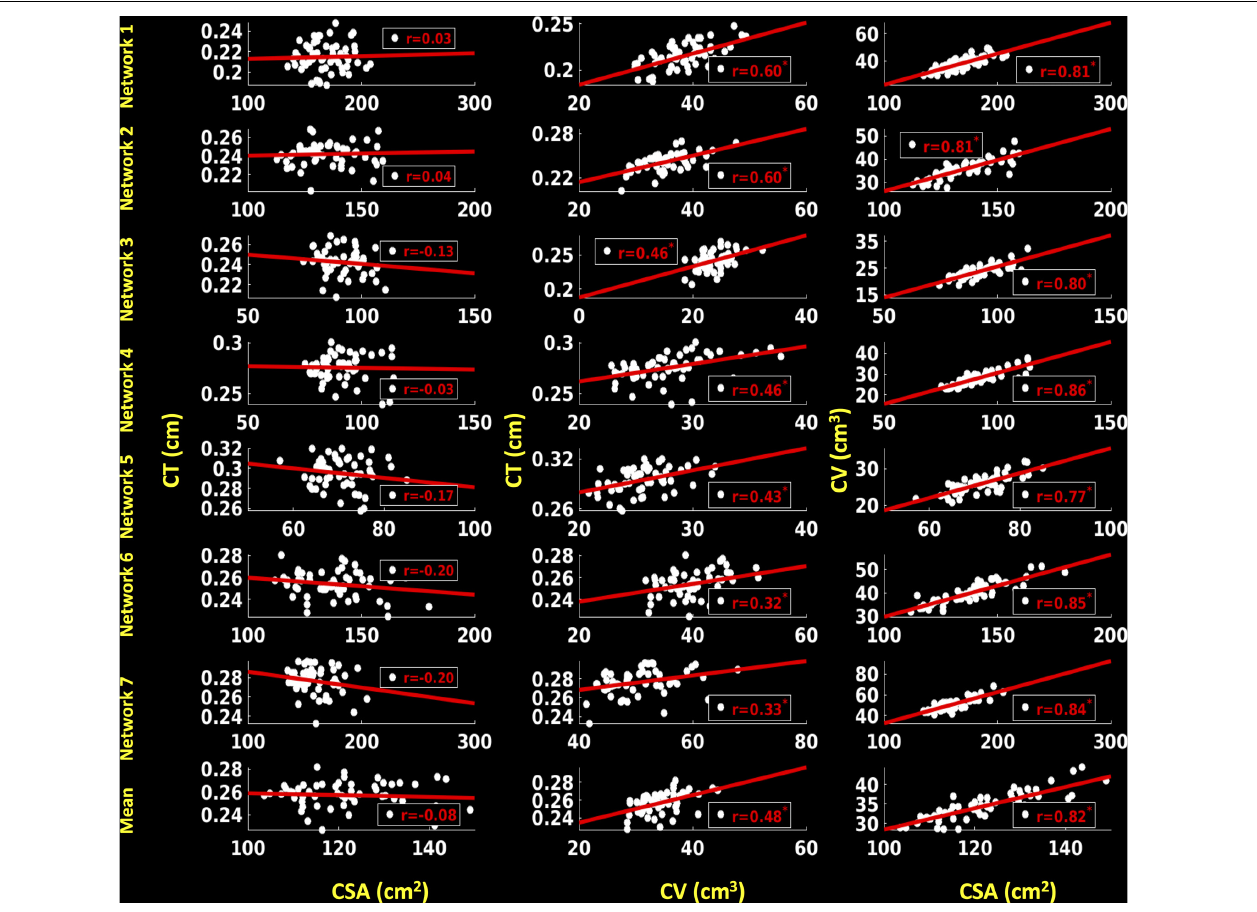
FIGURE 9 | Correlations between cortical surface area (CSA) and cortical thickness (CT), cortical volume (CV) and CT and between CSA and CV for right hemisphere. Linear plots showing non-significant association between CSA (cm 2 ) and CT (cm), significant or trend toward significant positive association between CV (cm 3 ) and CT (cm) ( ∗ p < 0.05, corrected for multiple comparisons), and significant positive association between CSA (cm 2 ) and CV (cm 3 ) ( ∗ p < 0.05, corrected for multiple comparisons) for seven functional networks and mean over seven functional networks on right